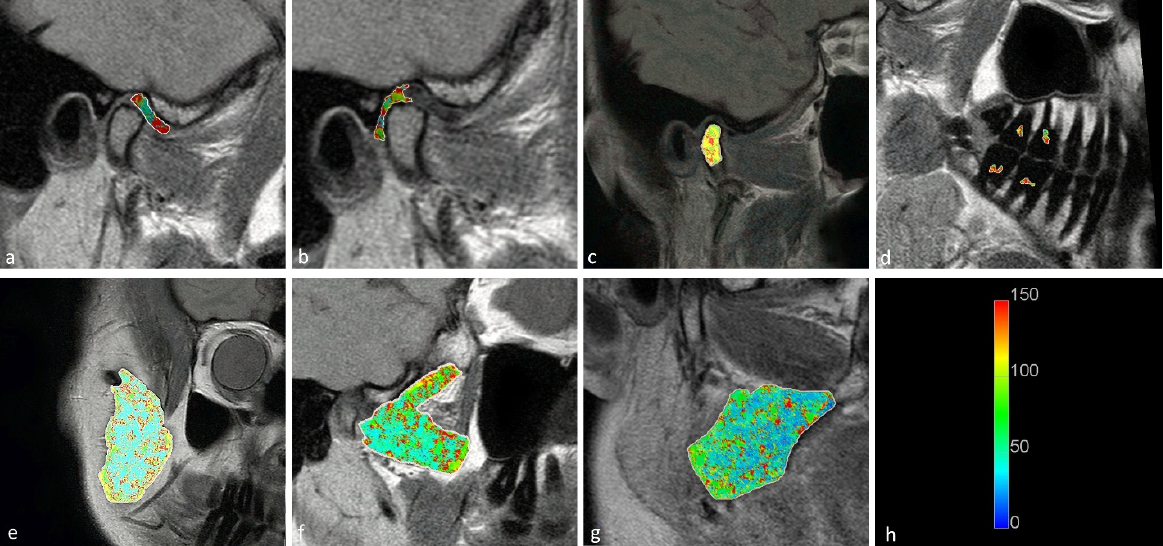
Figure 3. Long T2 maps obtained for the ( a ) disk; ( b ) retrodiscal tissue; ( c ) bone marrow of the condyloid process; ( d ) pulp; ( e ) m. masseter; ( f ) m. pterygoideus lateralis; and ( g ) m. pterygoideus medialis. ( h ) Color scale showing the reference T2 times in seconds.